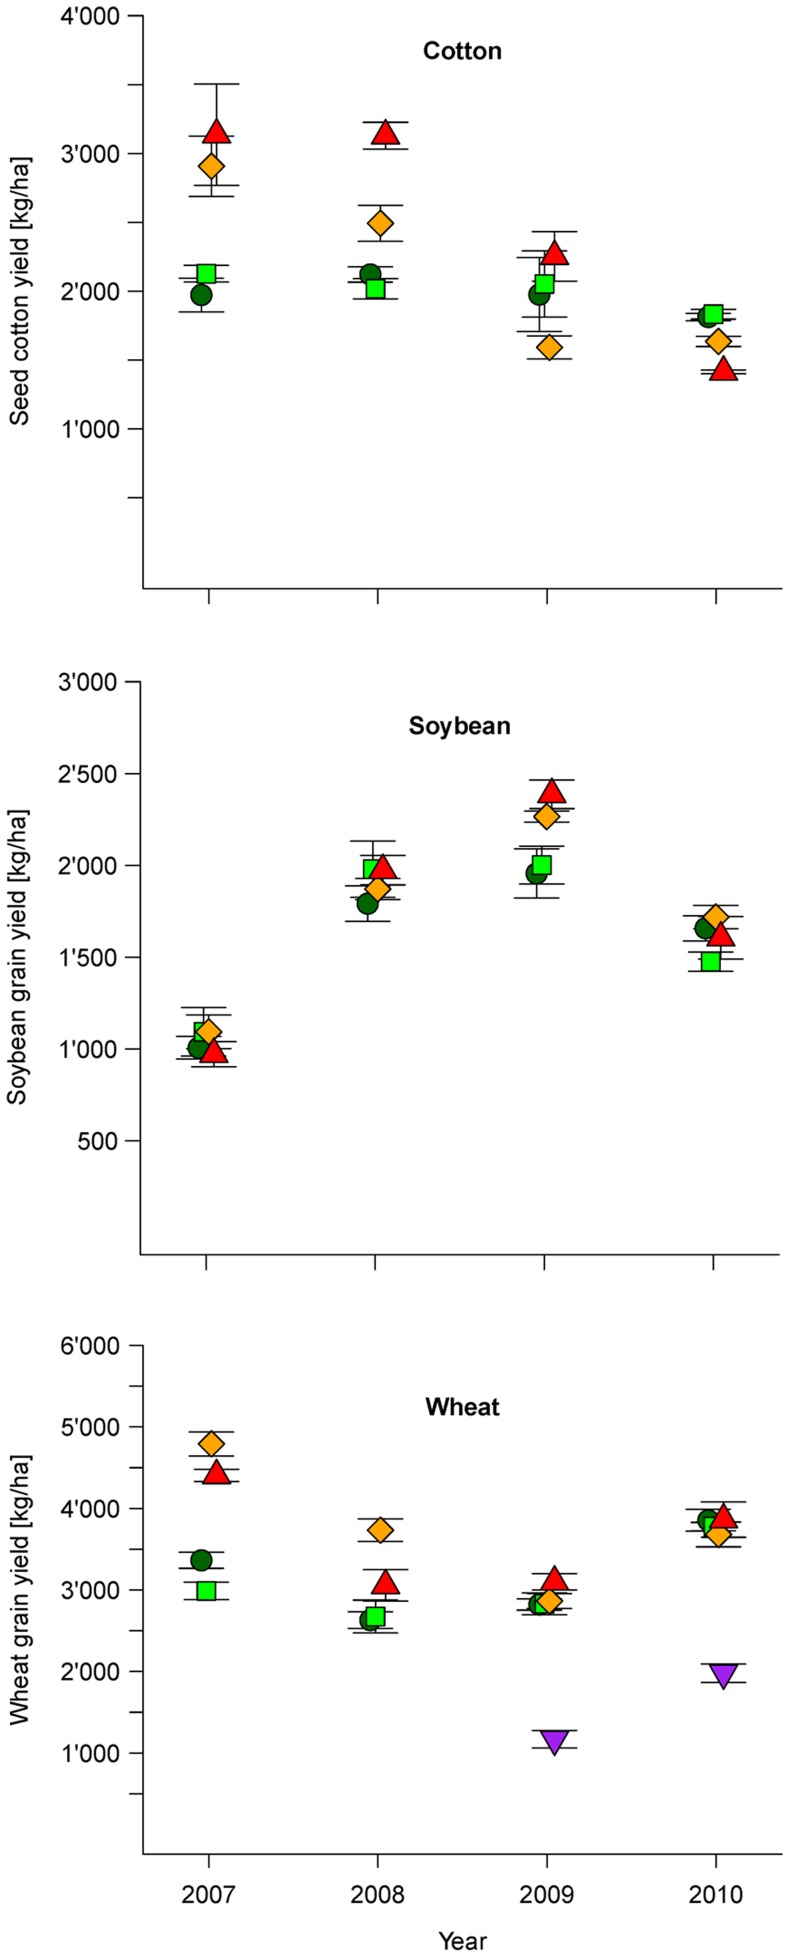
Yield (mean ± standard error) 2007-2010 in cotton, soybean and wheat.Farming systems: (•) biodynamic (BIODYN), (▪) organic (BIOORG), (♦) conventional (CON), (▴) conventional with Bt cotton (CONBtC), (▾) wheat after Bt cotton (wheat 2); In 2009 and 2010 Bt cotton was uprooted 2 months earlier to grow a second wheat crop (wheat 2) to reflect common practice of local Bt cotton farmers. Non-GM soybean and wheat varieties were cultivated in the CON and CON-BtC plots throughout the trial. Note the different scales on y-axes in the different panels of the graph.